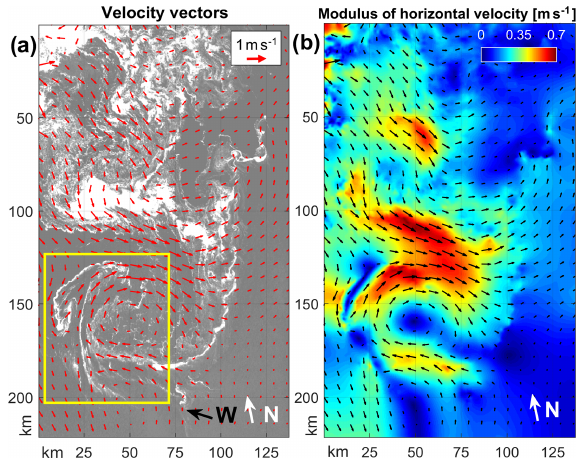
Figure 2. The horizontal velocity vectors calculated from two se- quential Sentinel-1A/B images acquired on 17 September 2017 over Fram Strait using the MCC method superimposed on (a) the SAR image and (b) map of the horizontal velocity (speed in color). Let- ters W and N mark the wind and the northern directions. Yellow frame in (a) shows the region enlarged in Fig.